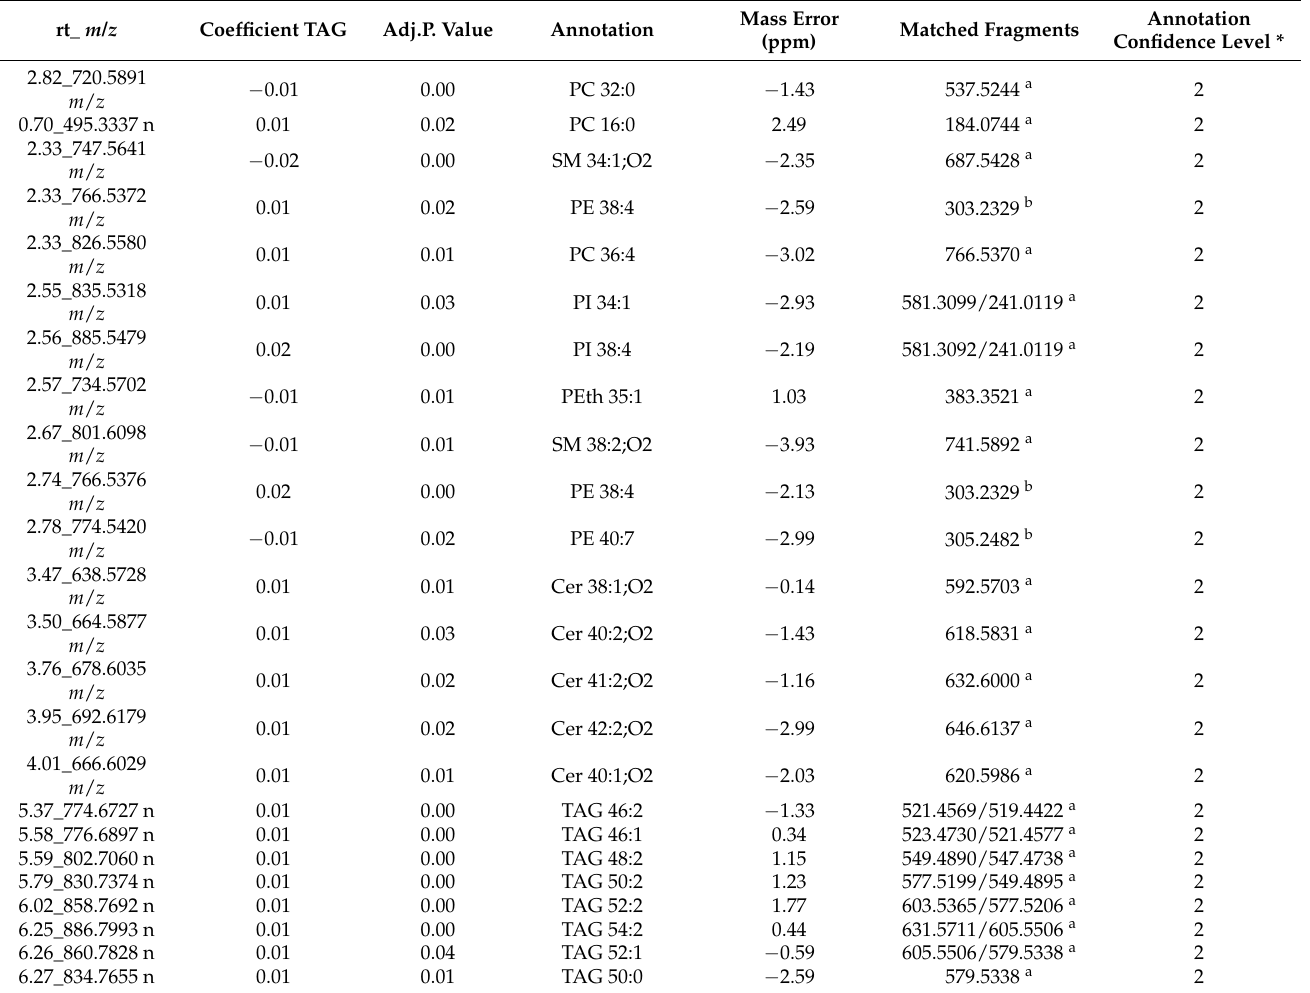
Table 2. MS-annotated lipids (rt_ m / z ) with statistically significant associations with serum TAG